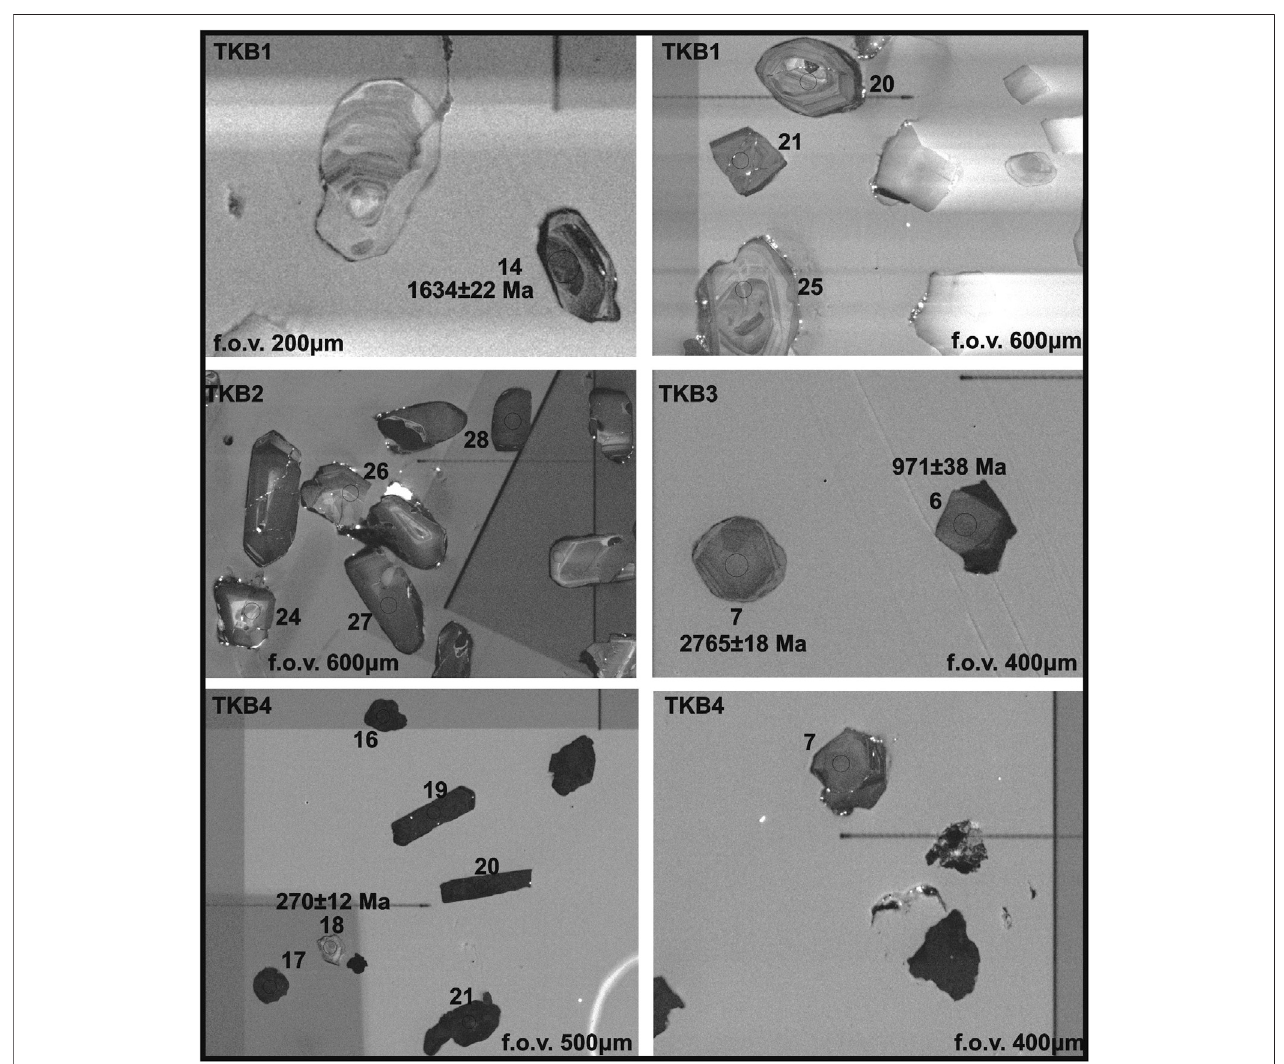
FIGURE 6 | CL images of zircon, sample numbers TKB-1, TKB-2, TKB-3, and TKB-4.